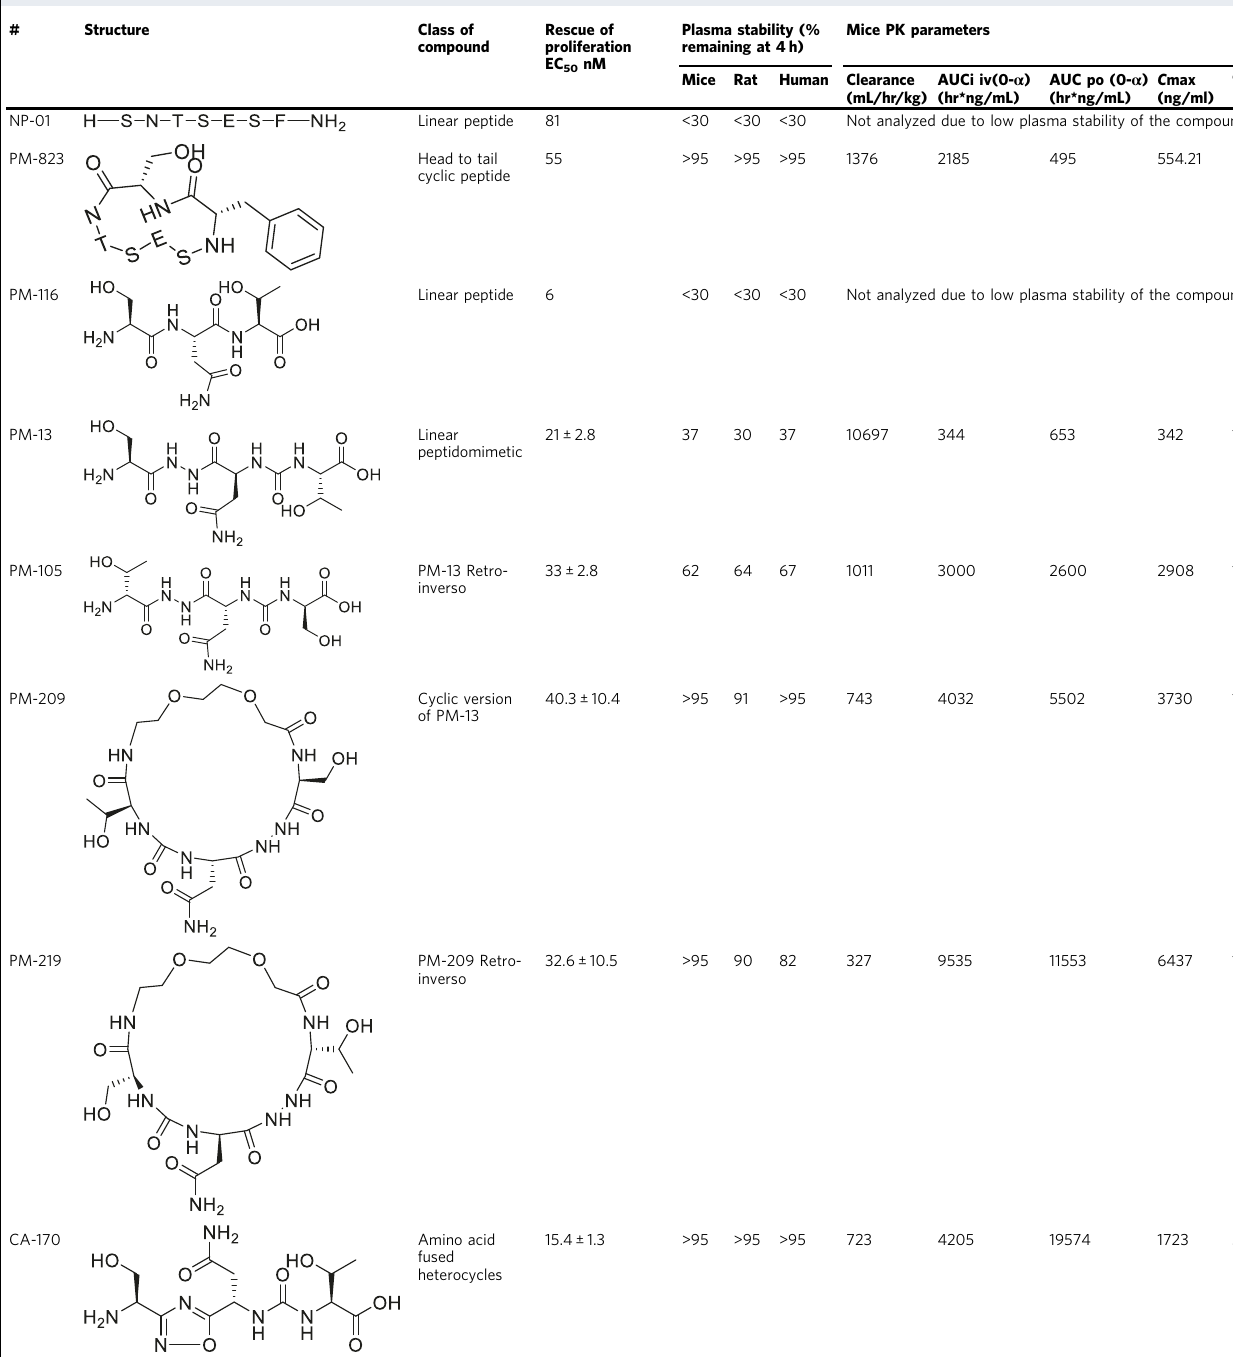
Table 1 Evolution of CA-170: pro fi les of hit and lead compounds.